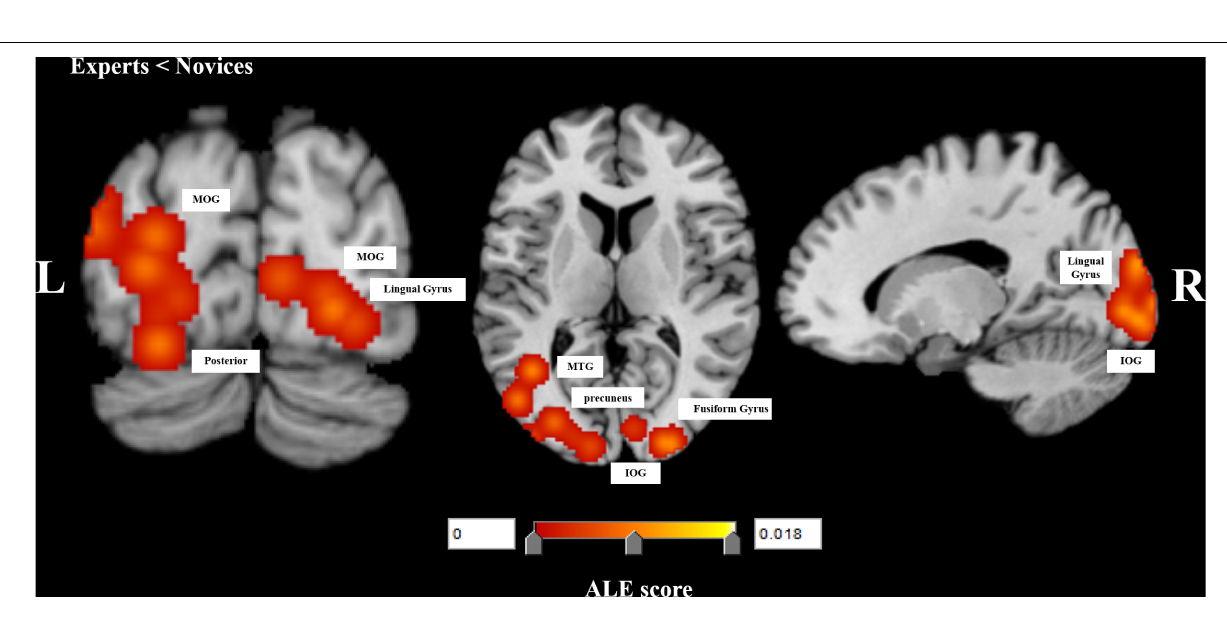
Frontiers in Human Neuroscience |